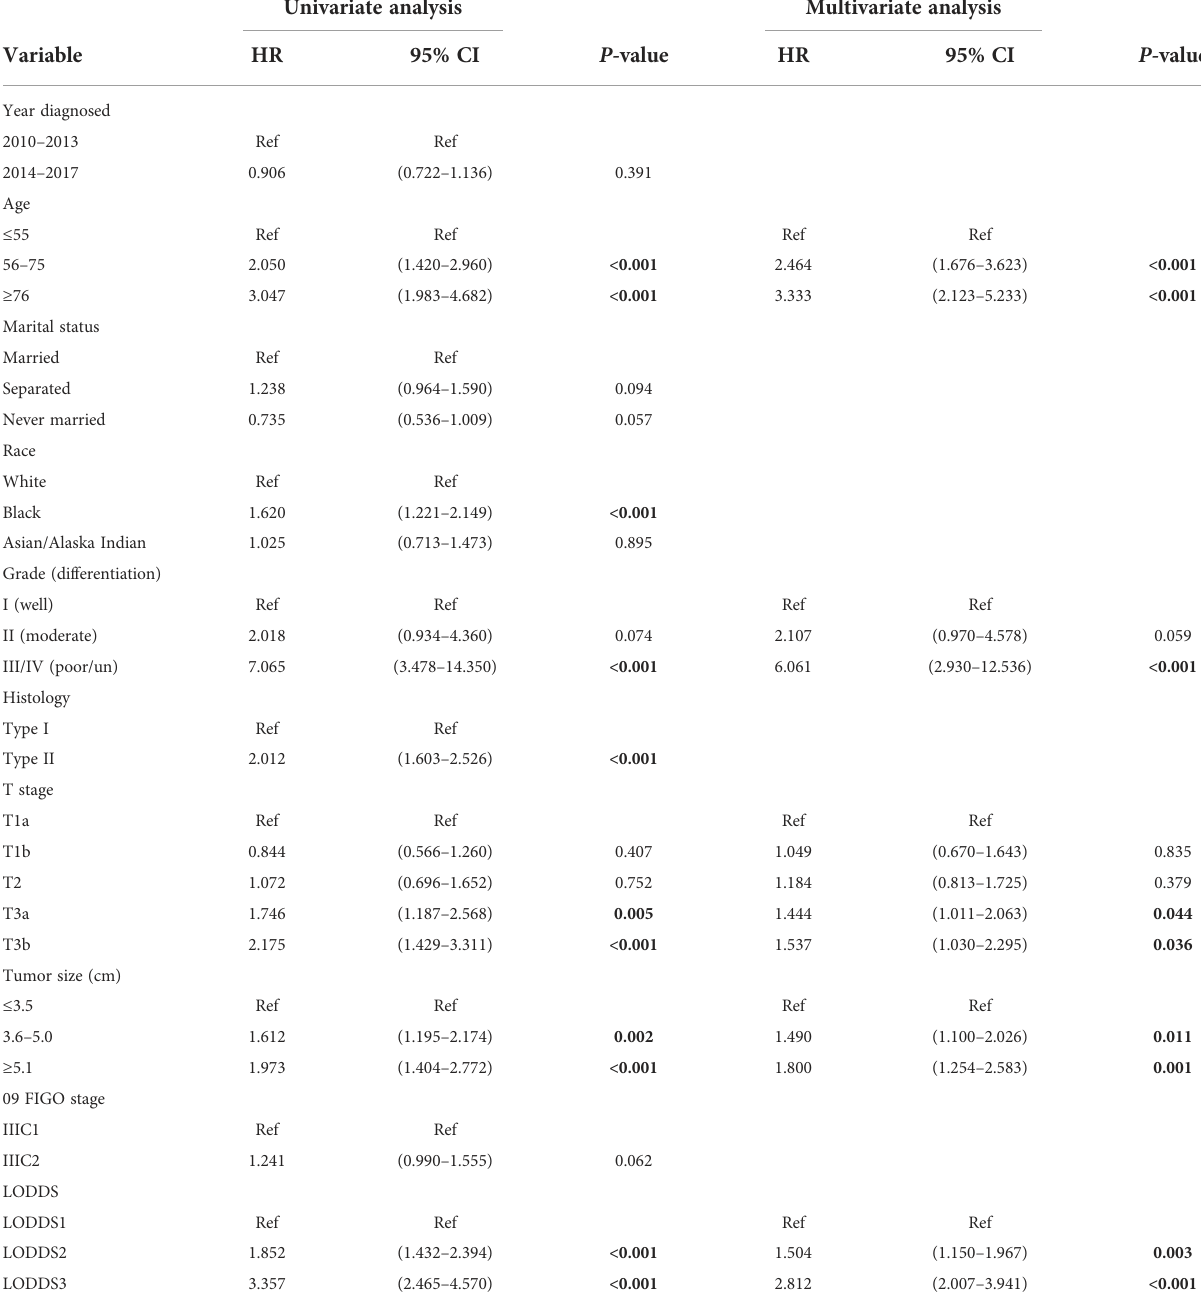
TABLE 2 Univariate and multivariate Cox regression analysis on variables for the prediction of overall survival in the training cohort ( N = 522). Univariate analysis Multivariate